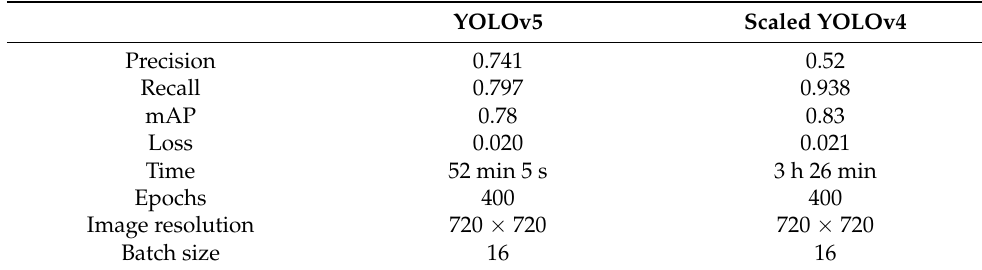
Table 7. Comparison of the results for parasite